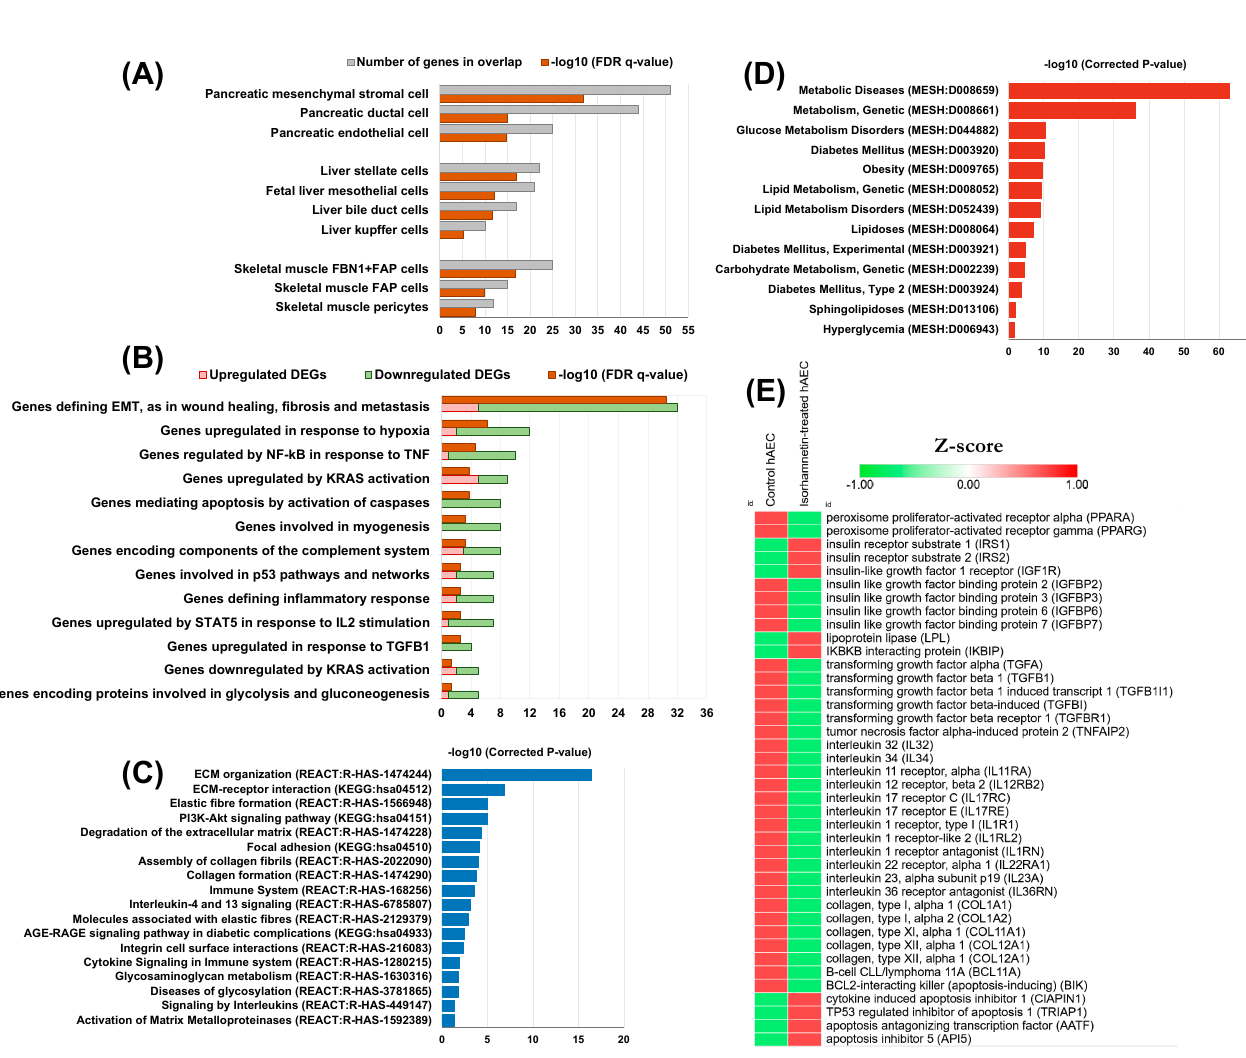
Figure 4. Whole-genome microarray analysis predicts the potential effect of the isorhamnetin on diabetes in a stem cell-based tool of hAEC. ( A ) Significantly enriched cell type signature gene sets (MSigDB of GSEA; https://www.gsea-msigdb.org/gsea/index.jsp, accessed on 26 November 2021); ( B ) significantly enriched hallmark gene sets (GSEA); ( C ) significantly enriched pathways (CTD; http://ctdbase.org/, accessed on 29 November 2021); ( D ) significantly enriched metabolic diseases (CTD); ( E ) heatmap for DM-associated gene expression. All data are available at Gene Expression Omnibus (GEO) GSE153149 (https://www.ncbi.nlm.nih.gov/geo/query/acc.cgi?acc=GSE153149, accessed on 24 November 2021).